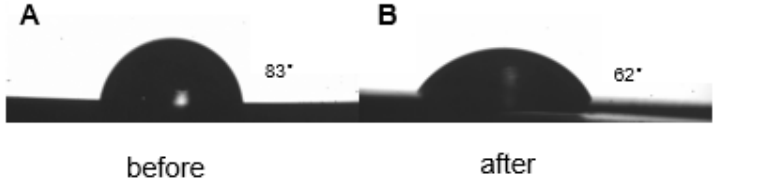
Figure 5. Hydrophilicity of PPDO film before and after plasma treatment: ( A ) before treatment ( B ) after treatment.